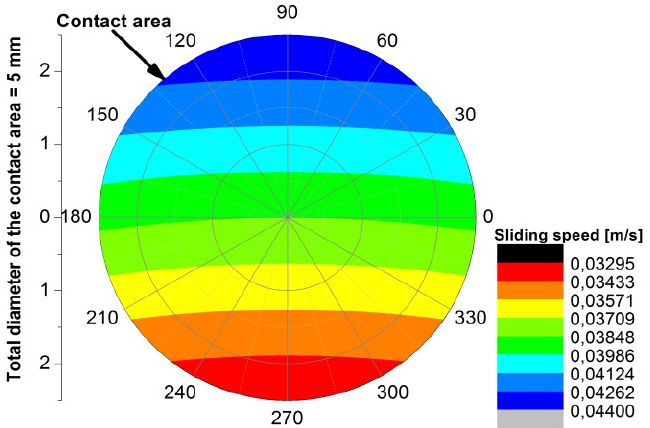
Figure 2. Map of the distribution of the sliding speed across the contact area.